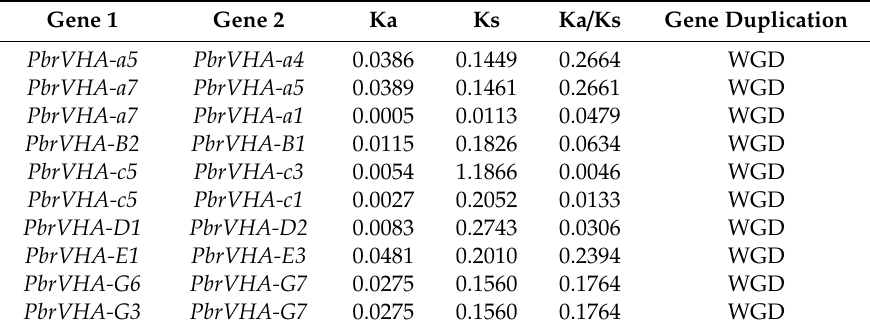
Figure 3. Chromosomal distribution and synteny analysis of the PbrVHA genes. Gene pairs with a syntenic relationship were joined by a line. Chromosome number was indicated on the inner side. Table 2. Ka, Ks, and Ka/Ks values of paralogous PbrVHA gene pairs.